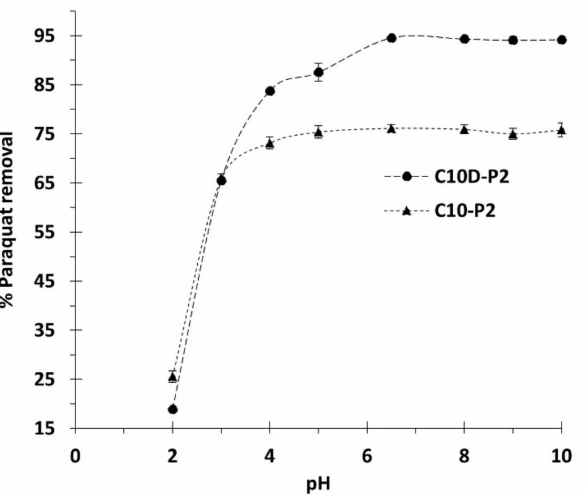
Figure 8. Influence of pH on paraquat removal (conditions: 2 g/L of adsorbent dosage, 25 mg/L of PQ initial concentration, 180 min of contact time, and temperature at 303